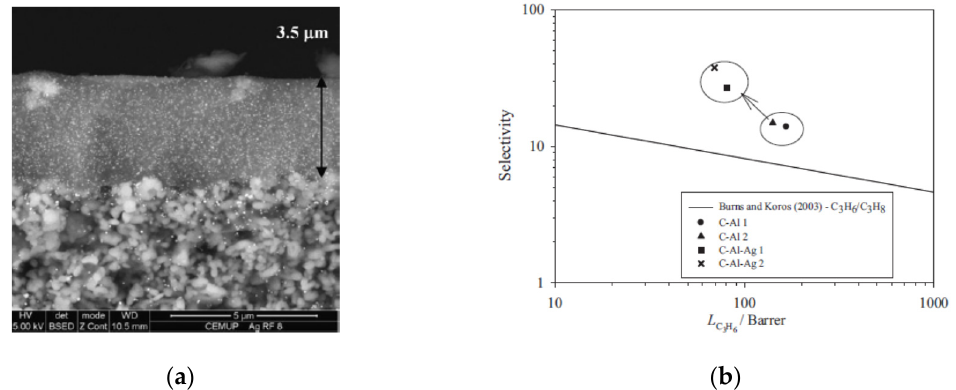
Figure 2. ( a ) SEM image of a supported composite Ag‐alumina‐CMSM, bright spots indicate the presence of Ag; ( b ) Gas permeation results for propene/propane and comparison with the respective upper bound plot. Reproduced with permission from [52], Elsevier, 2012. Table 1. Gas permeabilities of c-CMSM at 293 K in function of C/Al ratio [50].